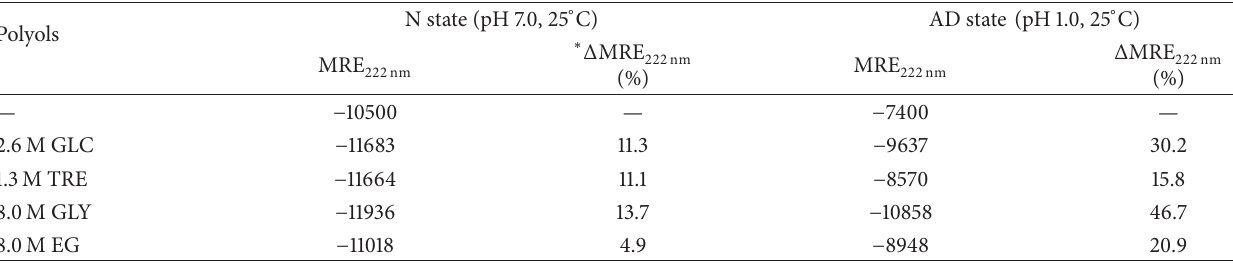
of different states of 222nm